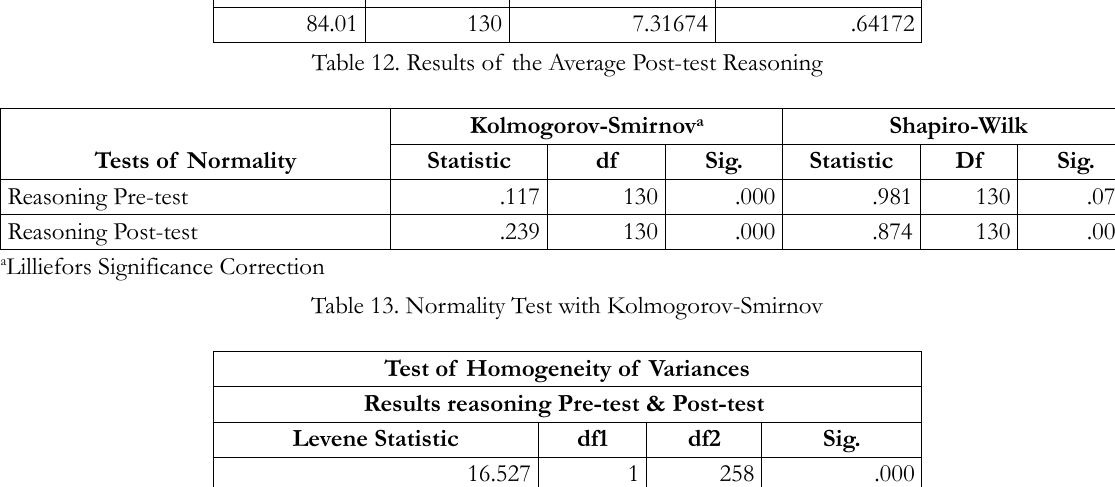
Table 14. Homogeneity Test